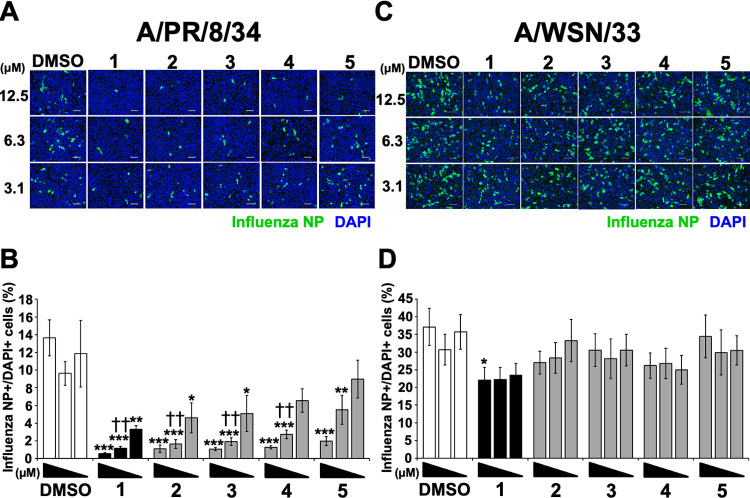
Image analysis of inhibitory effect of cyclobakuchiols A–D on influenza A viral infection.The corresponding concentrations of cyclobakuchiols A (2), B (3), C (4), and D (5) (3.1–12.5 μM; n = 9 each), (+)-(S)-bakuchiol (1) (3.1–12.5 μM; n = 9 each), or DMSO (0.031–0.125%; n = 9 each) were mixed with A/PR/8/34 (A and B) or A/WSN/33 (C and D) viruses and added to MDCK cells for 24 h. The infected MDCK cells were visualized by immunofluorescence staining of influenza A viral NP and then photographed under a microscope (A and C). The percentages of influenza A viral NP-positive cells per DAPI-positive cells were calculated based on the counts of influenza A viral NP-positive and DAPI-positive cells (B and D). The white scale bar in each image represents 100 μm. Data are expressed as the mean ± SEM of three independent experiments. *p < 0.05, **p < 0.01, ***p < 0.001 relative to DMSO-treatment. ††p < 0.01 relative to cyclobakuchiol D-treatment. The results were reproducible in this experiment.